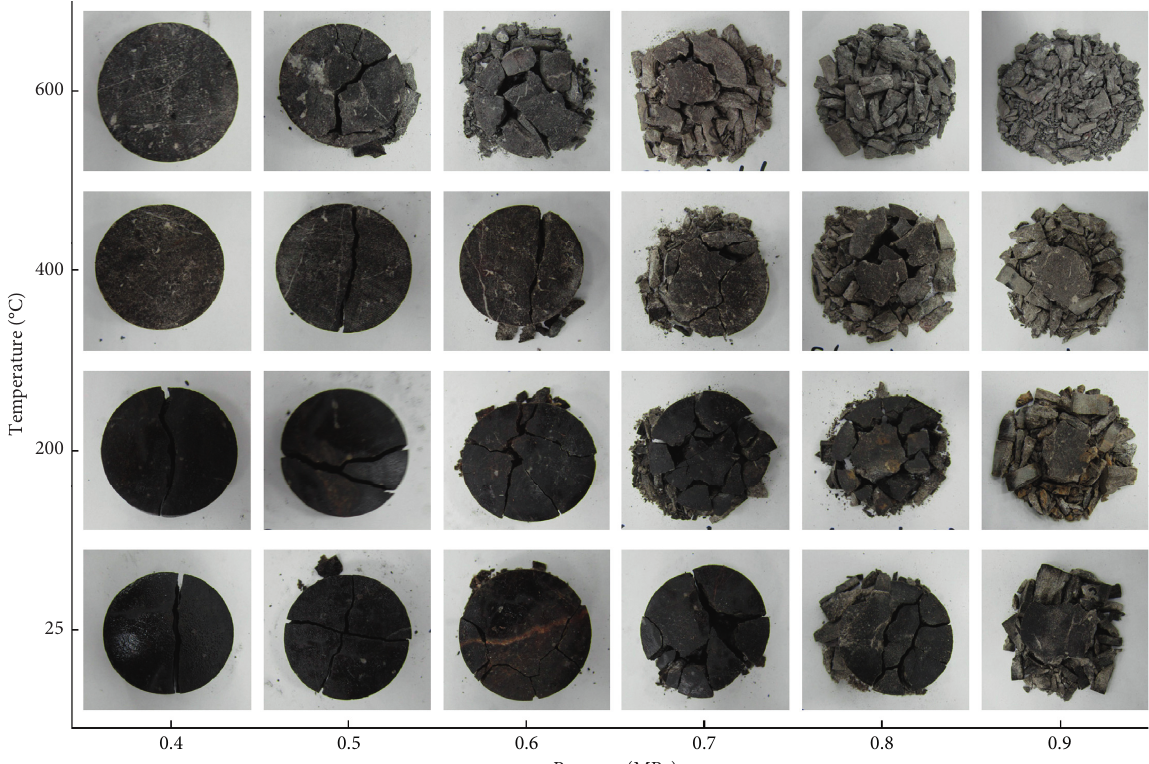
Figure 7: The failure modes of limestone specimen with various high temperatures under different impact air